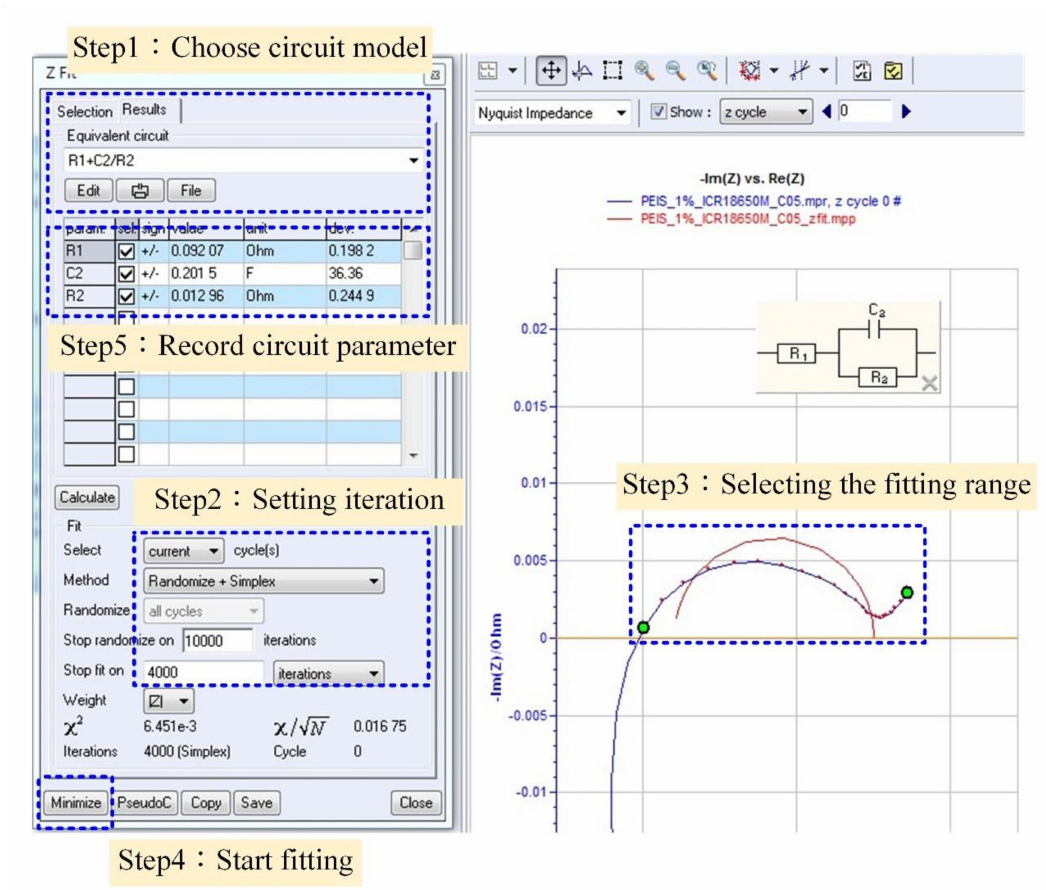
Figure 4. Illustration of the Z-Fit parameter fitting tool.